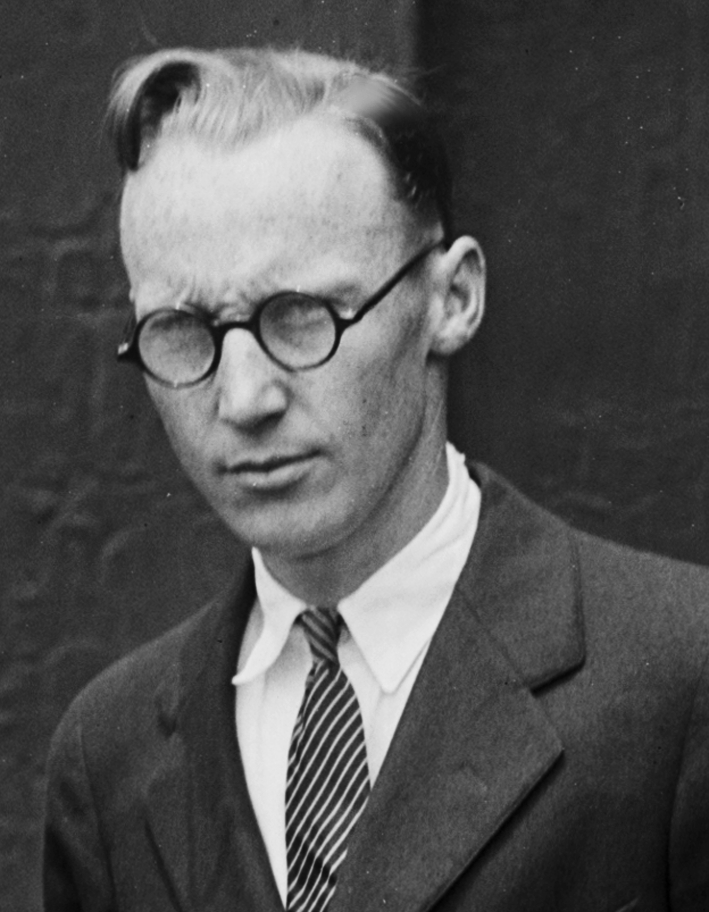
John ScopesOn May 7, 1925, John T. Scopes was arrested for teaching evolution at Rhea County High School in Dayton, Tennessee. When the famous “monkey trial” ended, Scopes was convicted of violating a Tennessee law that made it a crime to “teach any theory that denies the story of the Divine Creation of man as taught in the Bible, and to teach instead that man is descended from a lower order of animals.” Since that time, teachers have been on the front lines of the battles between evolutionary biology and alternatives such as intelligent design and creationism.